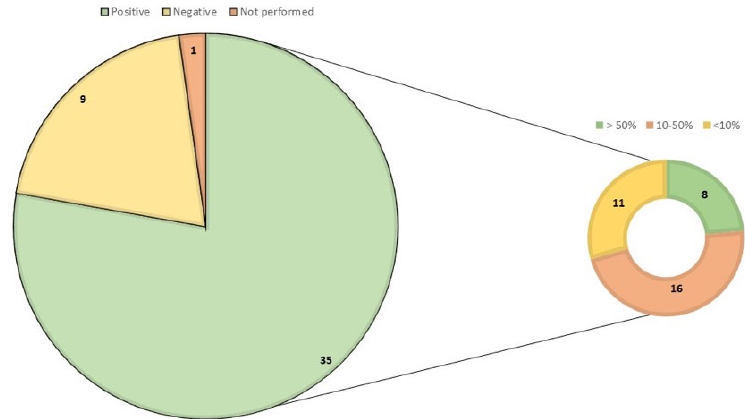
Figure 10. The graph shows the number of cases in which the amount of CoHb in central blood was analyzed. In terms of positive cases for CoHb, the graph on the right shows how many cases were detected in three different percentages, namely below 10%, between 10 and 50%, and above 50%. Only nine cases resulted negative for COHb (carboxyhemoglobin) or HCN (hydrogen cyanide) poisoning.